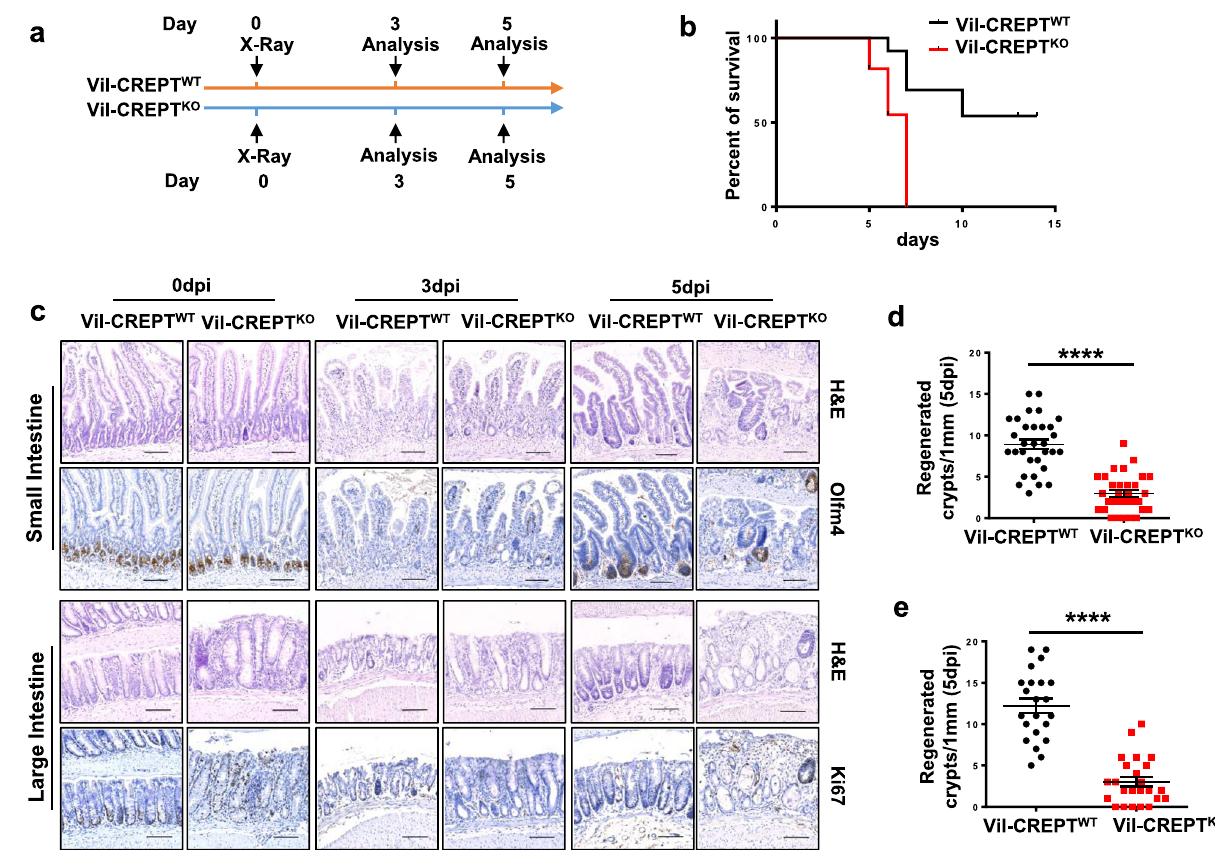
Fig. 3 CREPT is required for intestinal epithelium regeneration after X-ray irradiation. a Schematic diagram showing irradiation and analysis schedule. b The Kaplan-Meier survival curve of irradiated Vil-CREPT WT and Vil-CREPT KO mice with p = 0.0004 by one-sided log-rank test. n = 13 WT mice and n = 11 Vil-CREPT KO mice. c Representative H&E-stained, Olfm4-stained, and Ki67-stained sections of small and large intestines from Vil-CREPT WT and Vil- CREPT KO mice at different time after 10 Gy X-ray radiation. Images are representative of at least three animals for each condition. d Quanti fi cation of regenerated crypts per 1 mm small intestine marked by Olfm4 at 5 dpi. p < 0.0001 by 2-tailed Student ’ s t -test. n = 3 independent experiments. e Quanti fi cation of regenerated crypts per 1 mm colon marked by Ki67 at 5 dpi. p < 0.0001 by 2-tailed Student ’ s t -test. n = 3 independent experiments. Statistics data represent mean ± SEM. Scale bars, 100 μ